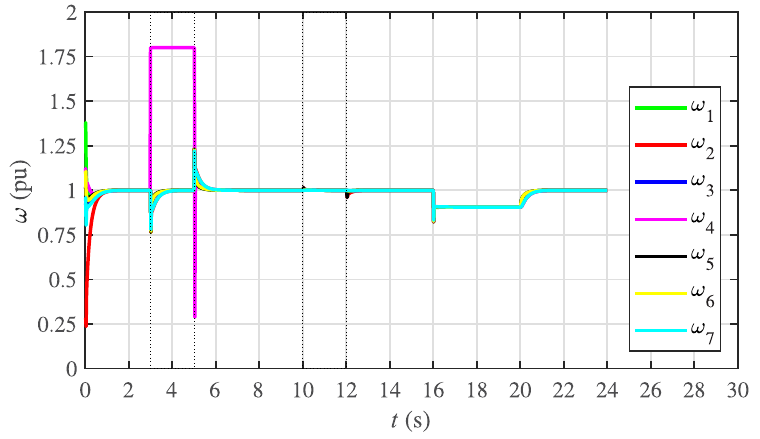
Fig 38. Frequency regulation with leader-follower and leaderless consensus under case 4.